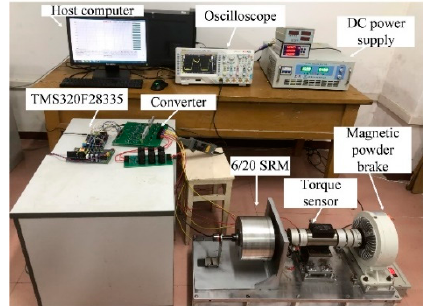
Figure 14. Experimental platform of the SRM prototype .